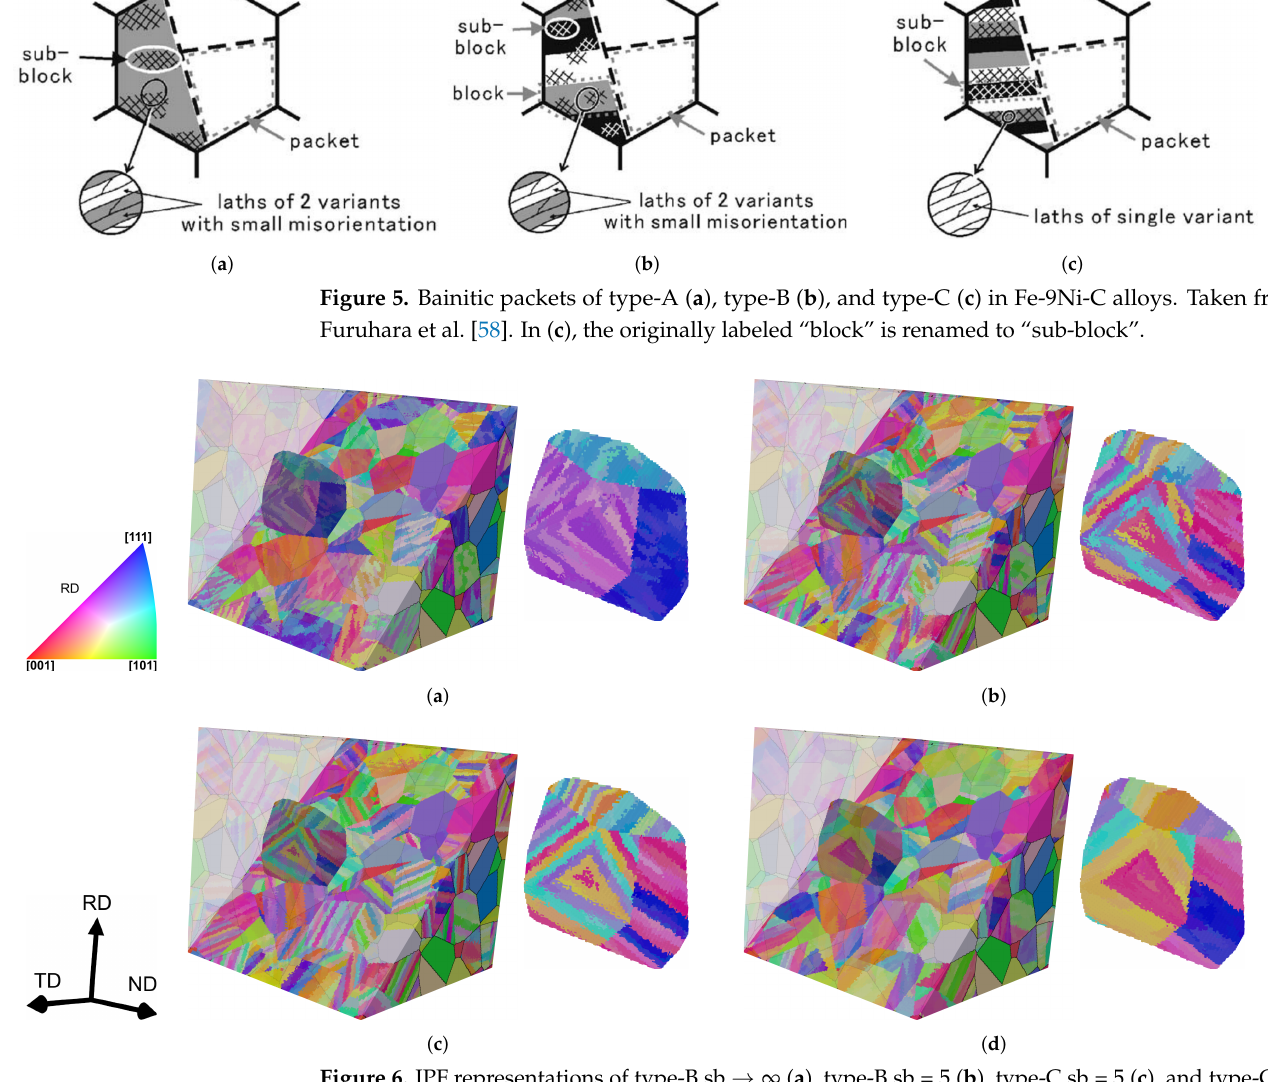
∞ ( a ), type-B sb = 5 ( b ), type-C sb = 5 ( c ), and type-C sb Figure 6. IPF representations of type-B sb → = 15 ( d ) RVEs of material S 1 . The RVEs are clipped with a plane on the left to show the same single grain extracted which is magnified on the